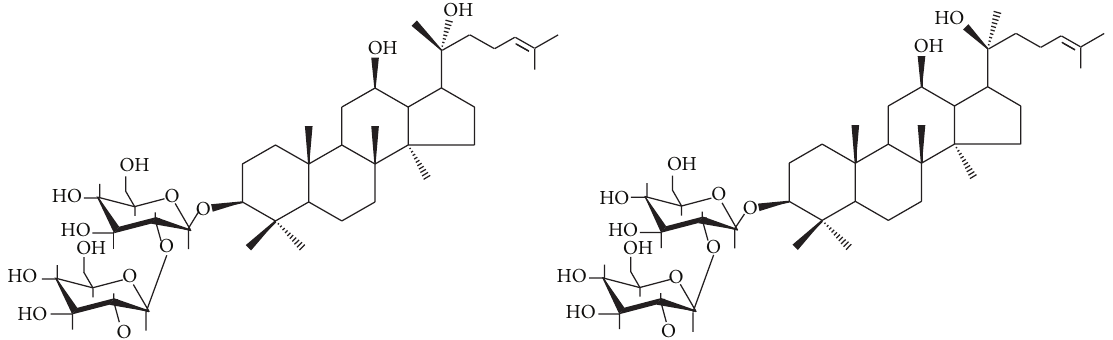
Figure 1: Structural formulas of 20(R)-Rg3 and